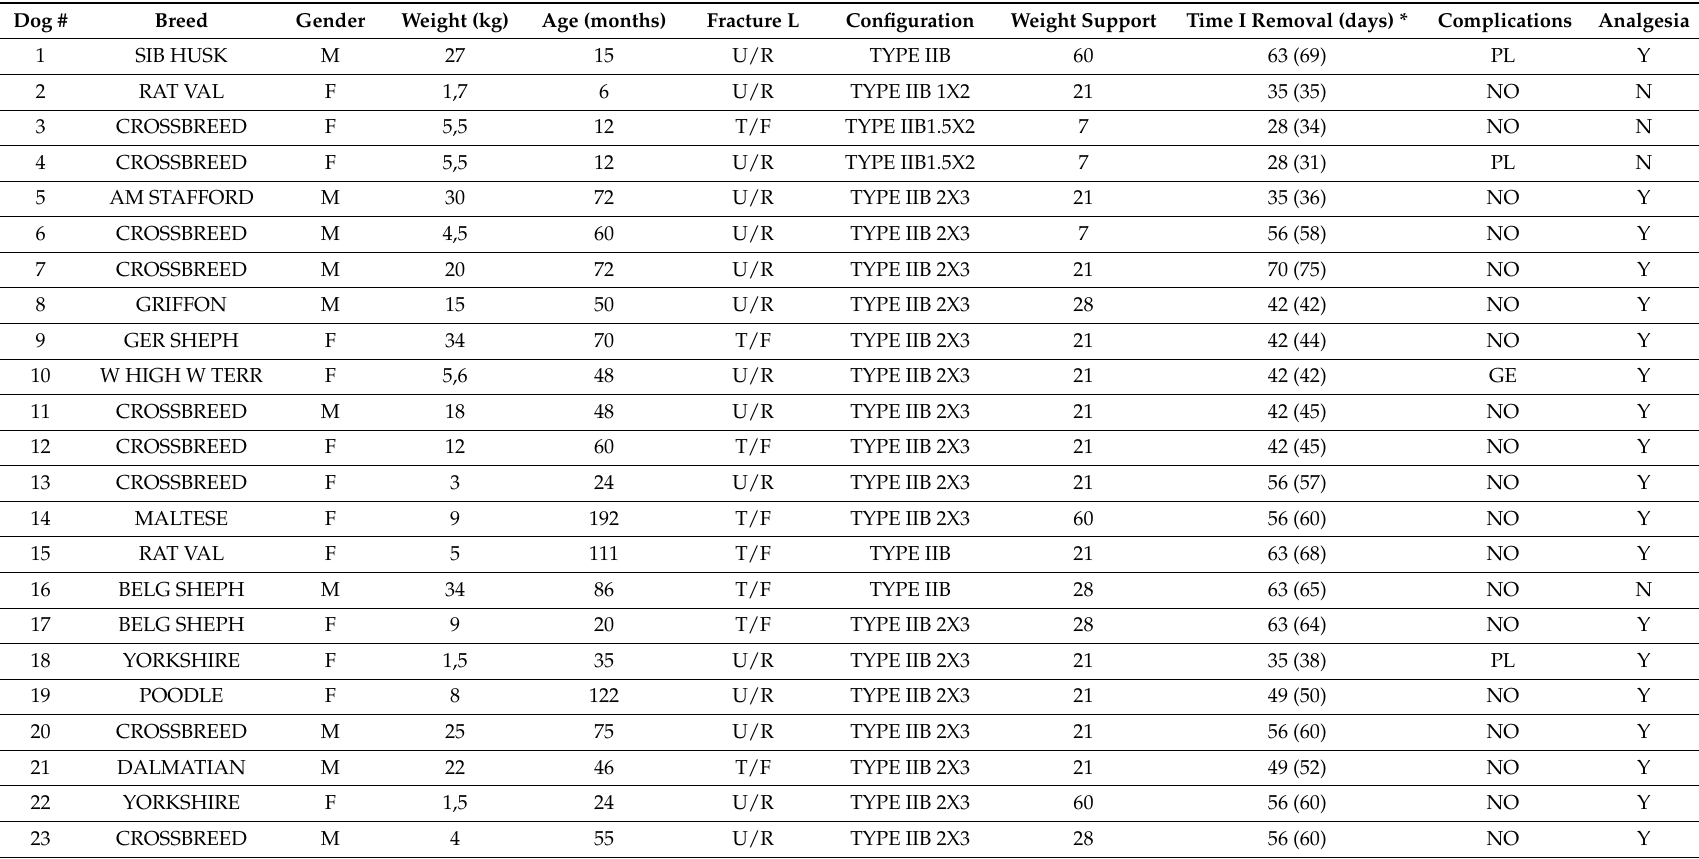
Table 2. Individual data and main results for SS